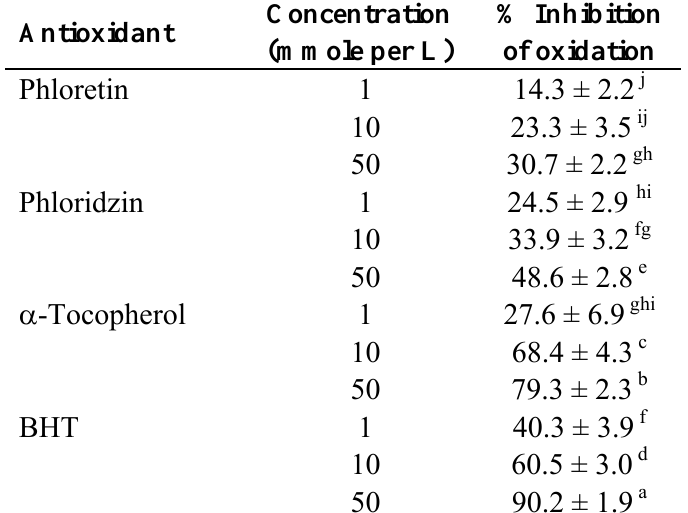
Data represent the mean (n = 6) of two independent experiments ± SD. Superscripts in columns without letters in common differ significantly ( P <